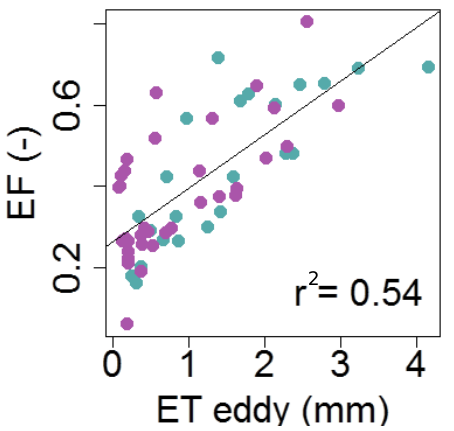
Figure 8. Correlation between estimated EF (y-axis) and measured ET (x-axis) for both years 2005 (gray) and 2006 (purple) ( n =